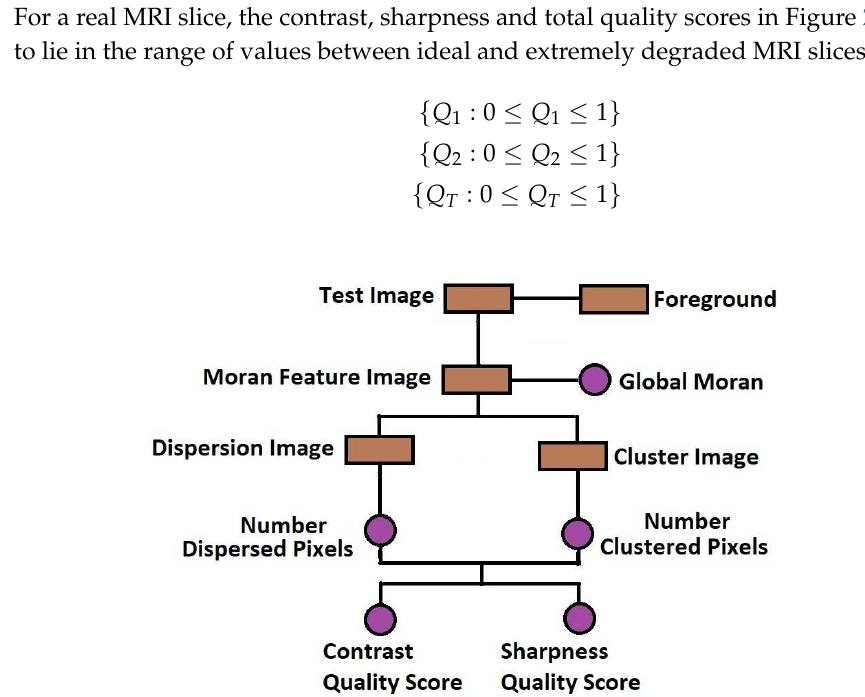
Figure 1. Flow chart of the proposed method for blind noise-based quality assessment in MRI